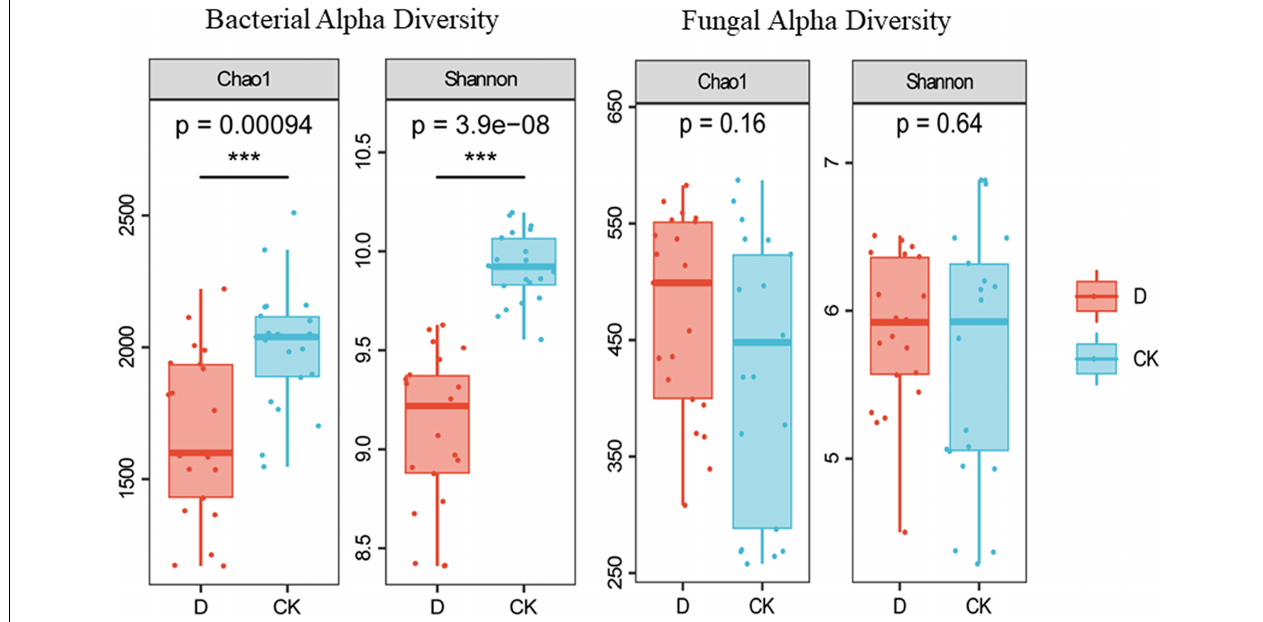
FIGURE 2 | Alpha-diversity of bacterial and fungal communities in the garlic cropping obstacle soil (D) and healthy control soil (CK). *** Indicates statistically significant difference at P < 0.001.